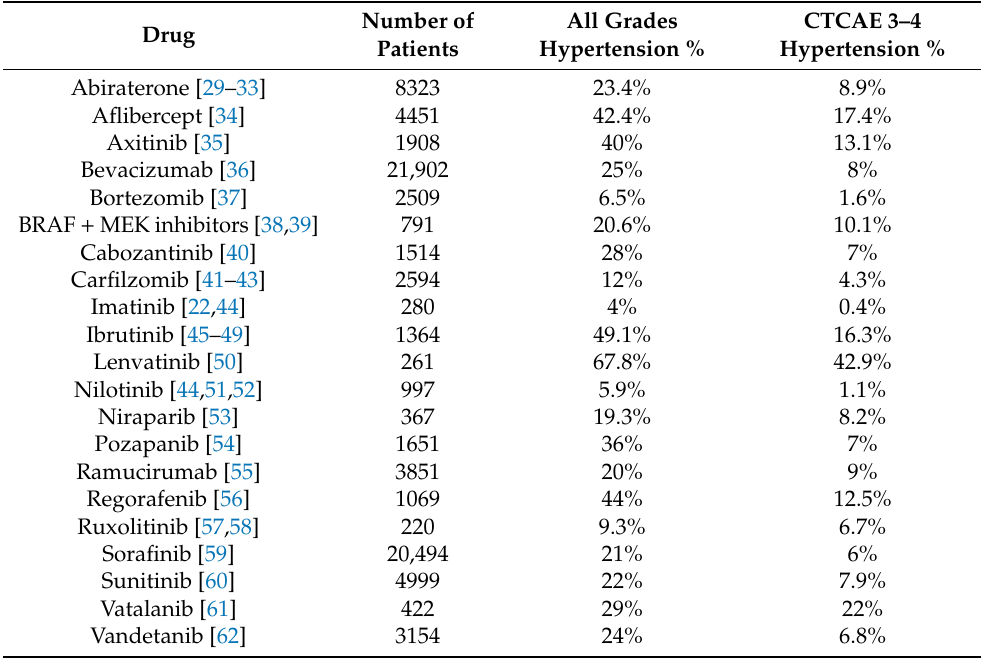
Table 2. Hypertensive cardiotoxicities in novel cancer